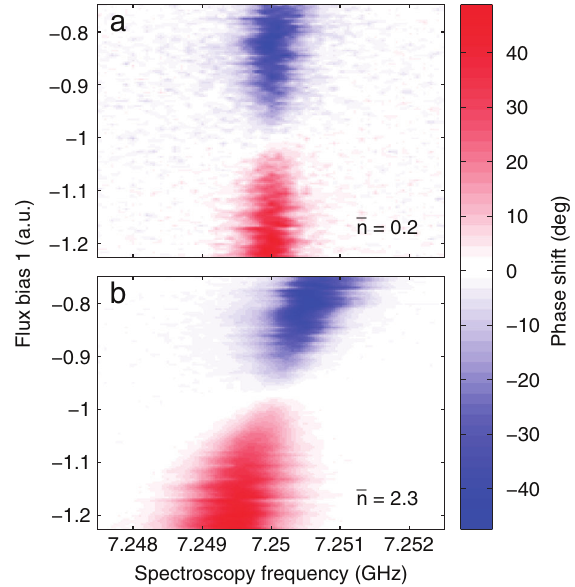
Fig. 2 Tunable dispersive coupling. Phase shift of the cavity transmission is monitored when a second spectroscopy tone sweeps around the qubit frequency. a Qubit frequency is fi xed at 7.25 GHz when intracavity photon number n ¼ 0 : 2 . The phase shift switches sign when χ − crosses zero. b When n ¼ 2 : 3 , upward (downward) AC Stark shift of the qubit frequency illustrates positive (negative) χ − . The spectroscopy signal vanishes near V 1 = − 0.95 V, where χ − approaches